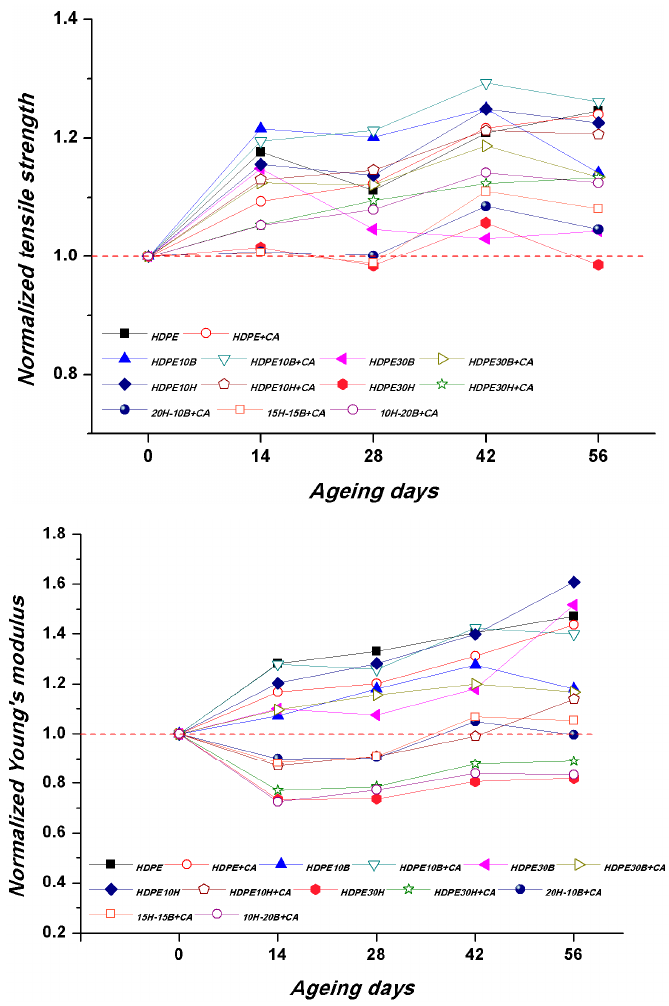
Figure 5. Evolution of the normalized mechanical properties as a function of exposure time.